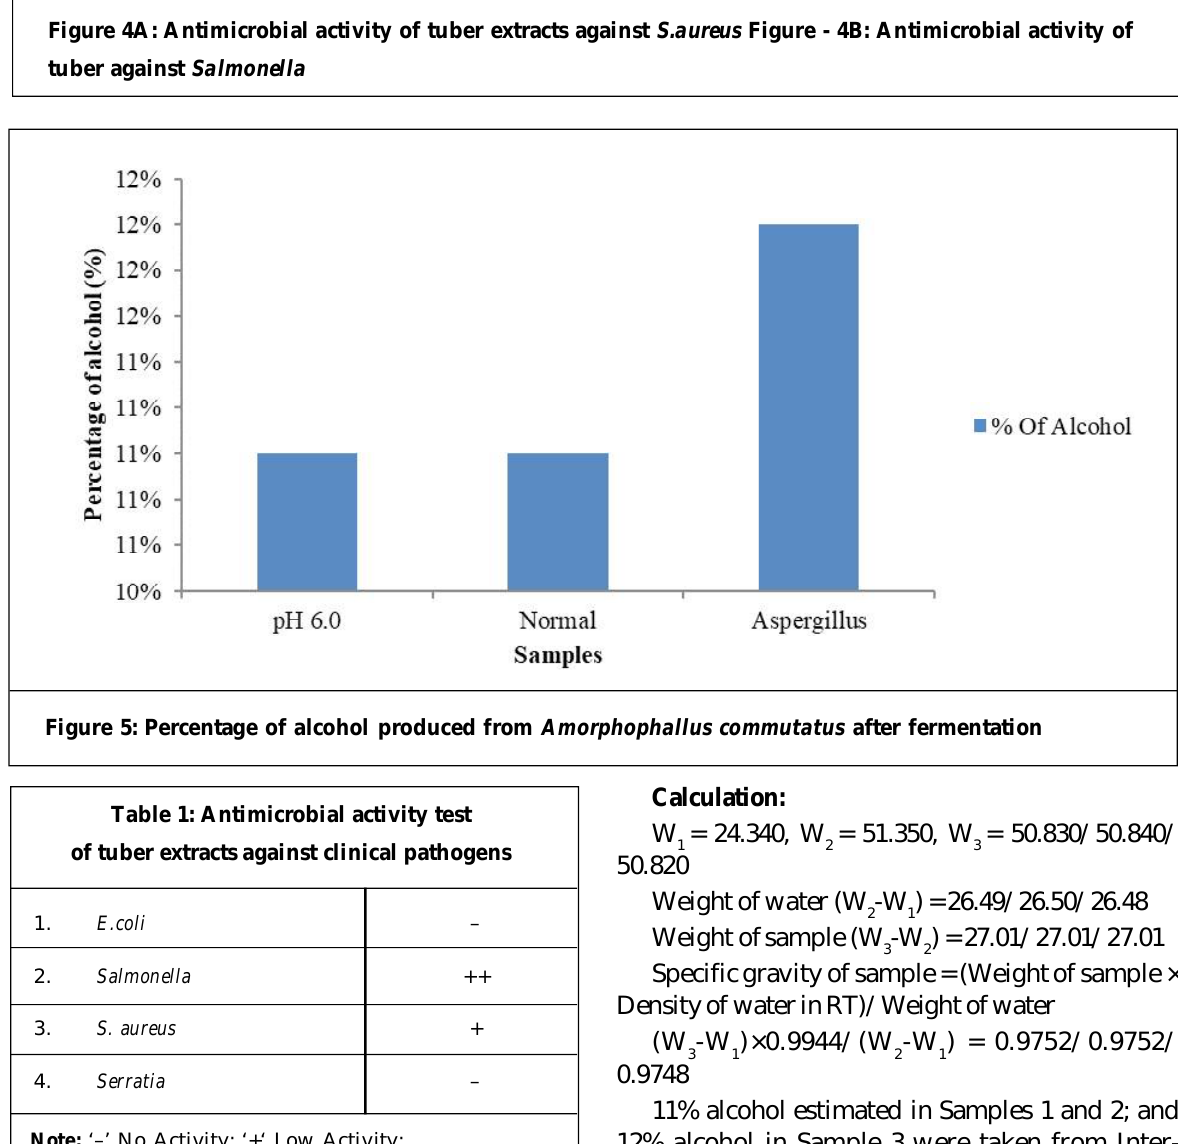
Figure 4A: Antimicrobial activity of tuber extracts against S.aureus Figure - 4B: Antimicrobial activity of tuber against Salmonella